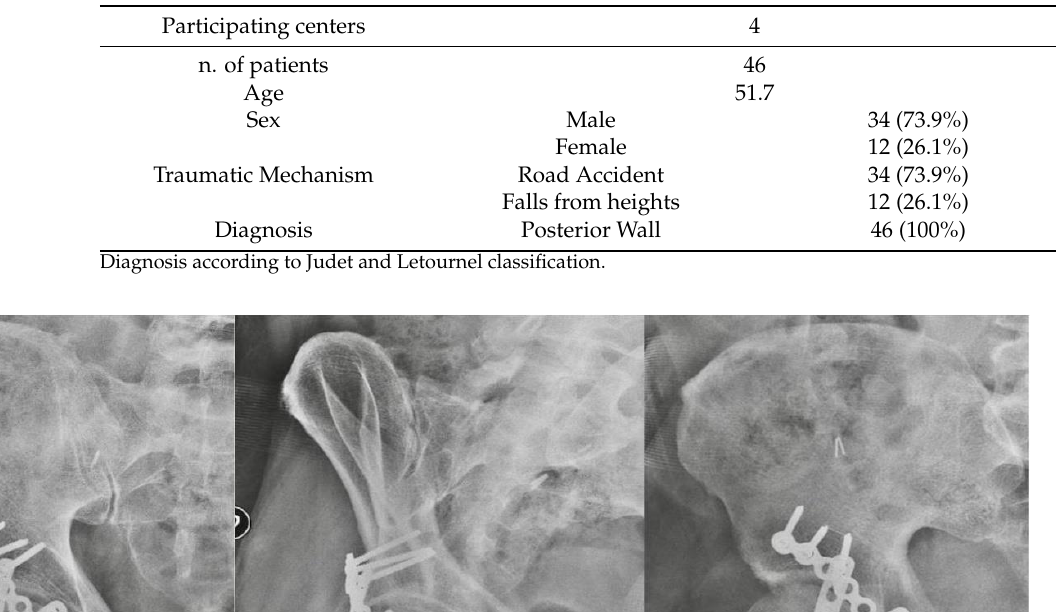
Table 1. Demographic data of the patients from the participating centers.